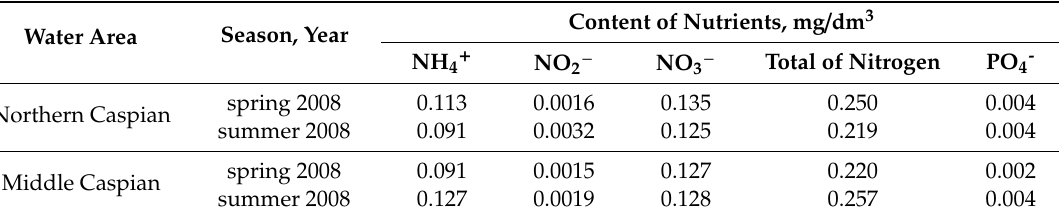
Table 9. Content of nutrients in the water of the Northern and Middle Caspian (by: [54]). Water